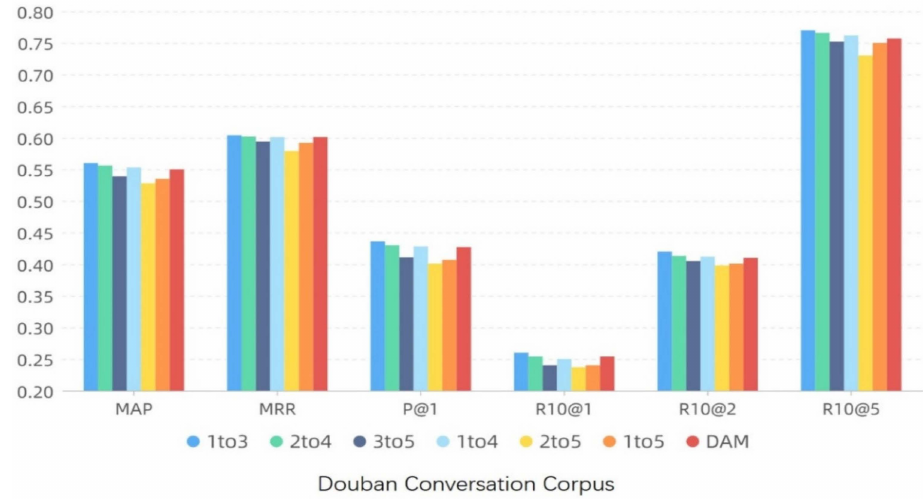
Figure 8. Comparison test results of granularity size layer selection (Douban Conversation